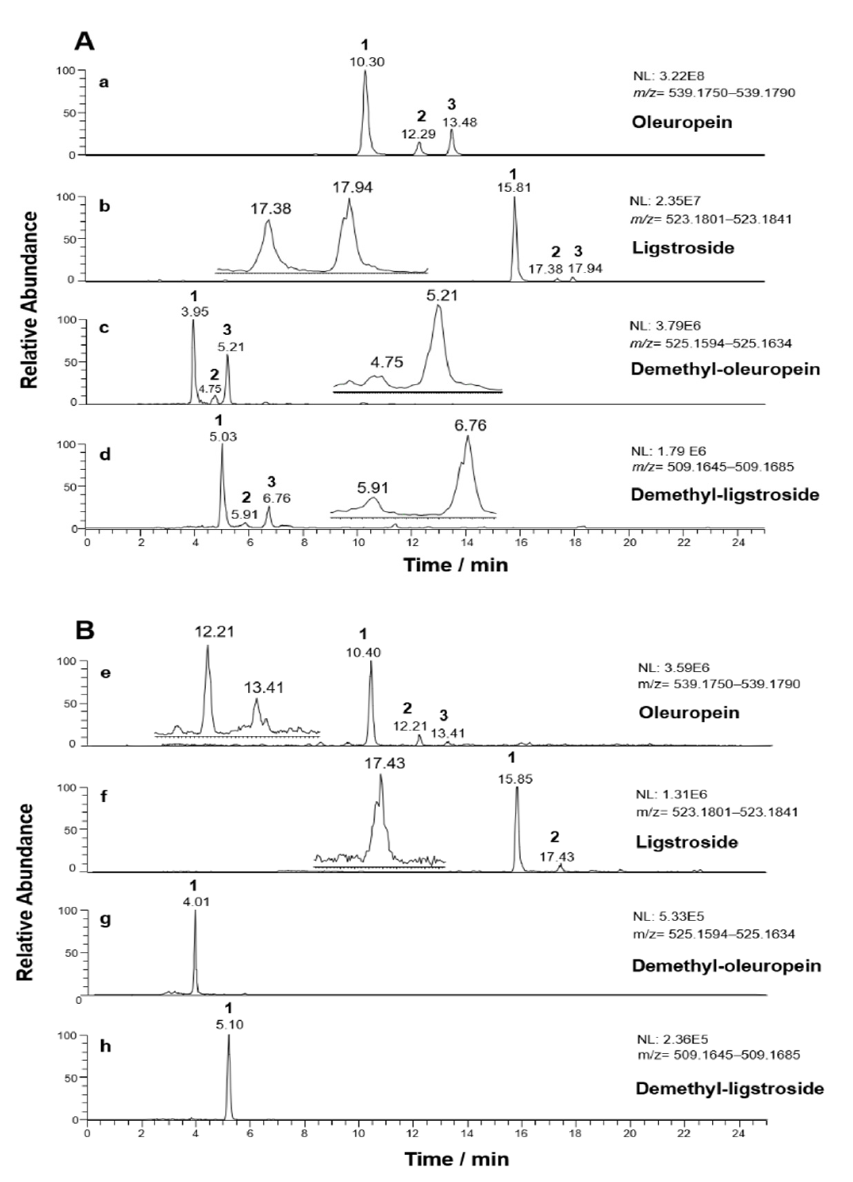
Figure 2. Extracted Ion Current (XIC) chromatograms (extraction window width: 0.0040 m / z units) obtained after RPLC-ESI(-)-FTMS analyses of Coratina leaves ( A ) and drupes ( B ) extracts for exact m / z ratios corresponding to the [M-H] − ions of oleuropein (panels a , e ), ligstroside (panels b , f ), and the respective demethylated forms (panels c , g and d , h ).